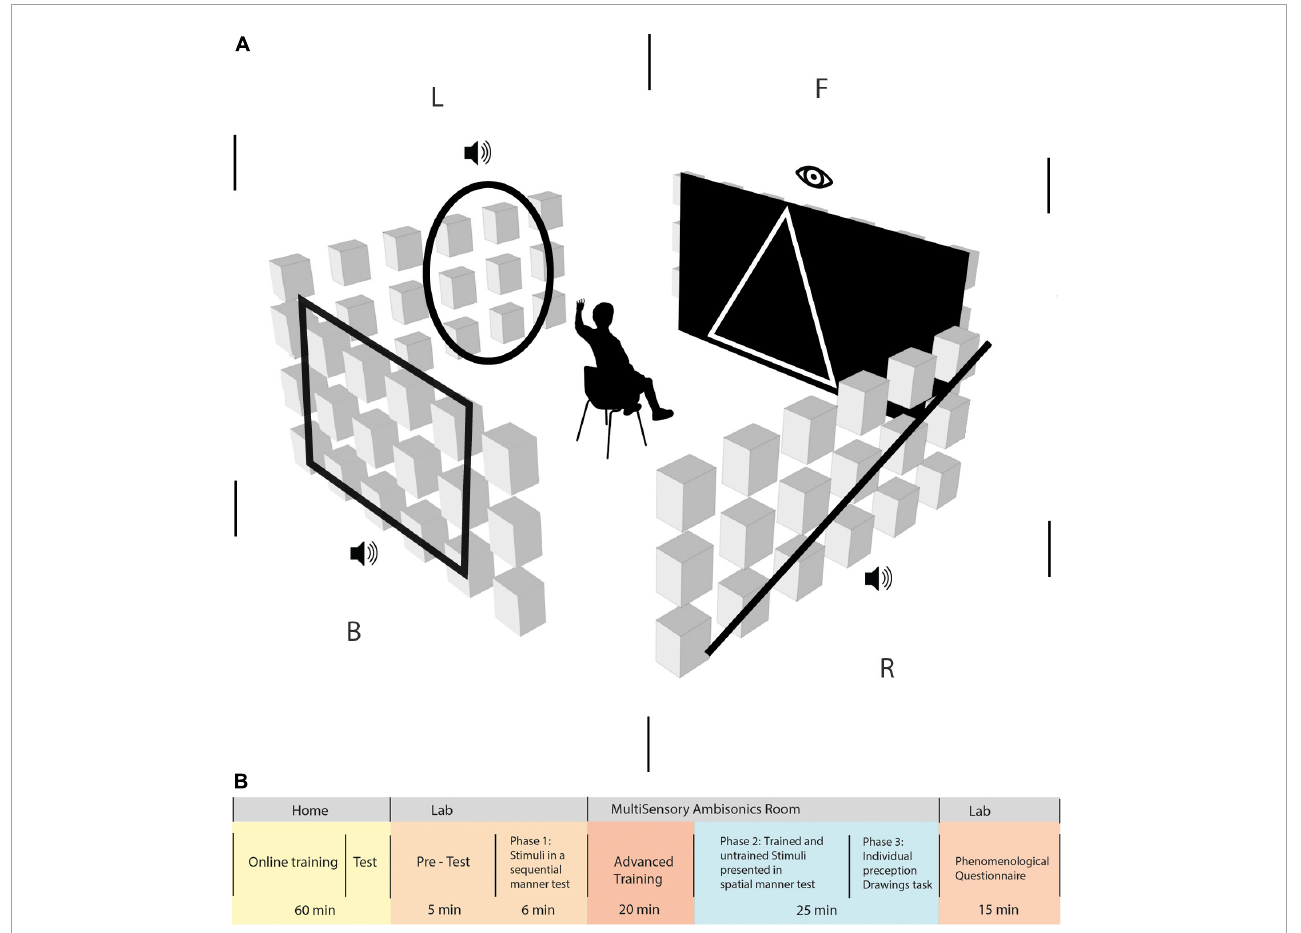
FIGURE1 (A) Simulation of the Vision360 experiment in the multisensory room at the lab. The participants sat in the middle of the room, 2 m away from each wall, at an ear height of 1.4 m. An ambisonic system operated 21 speakers on every wall, with the corner speaker column shared among adjacent walls. F | R | B | L represents the division of space to front, right, back, and left, respectively, in an egocentric manner (in relation to the participant’s body and position). Participants were required to focus on the front side of the room, where they perceived a visual stimulus and then an auditory stimulus. It appeared only on the participants’ right, back, and left sides, in this order. Trained EyeMusic shapes and untrained shapes are perceived as stimuli both visually and auditorily. (B) Study outline. Participants went through various phases to complete the experiment: 60 min of basic training on the EyeMusic SSD at home. Following this, participants who passed the online training test at home were invited to the experiment performed at the lab and in the MultiSensory Ambisonics room. Upon the arrival of the participants to the lab, they went through a 5-min pre-test on the EyeMusic SSD material before moving on to phase 1 of the experiment. Phase 1 of the experiment was a test of stimuli presented sequentially for 6 min. Then, they moved on to the advanced training phase, where stimuli were presented to them in the ambisonics system for 20 min. Phase 2 of 25 min was a test that consisted of trained and untrained stimuli, which was presented spatially in the room. Then, they moved to phase 3, where participants were asked to draw the stimuli they perceived, and finally, they took a phenomenological